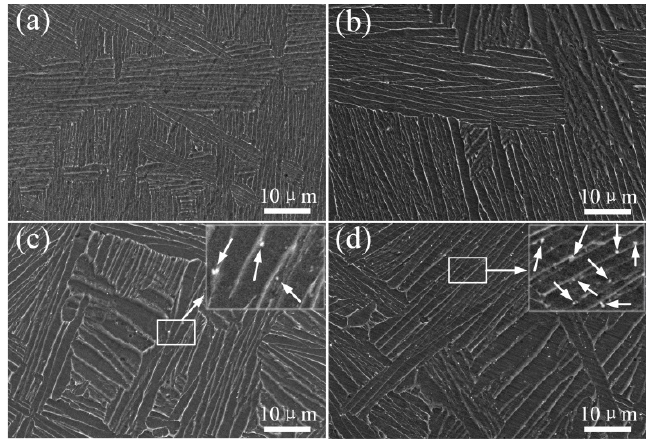
Figure 8. SEM images of Ti6Al4V- x Er casting alloys: ( a ) x = 0; ( b ) x = 0.2; ( c ) x = 0.4; ( d ) x = 0.6 wt %.